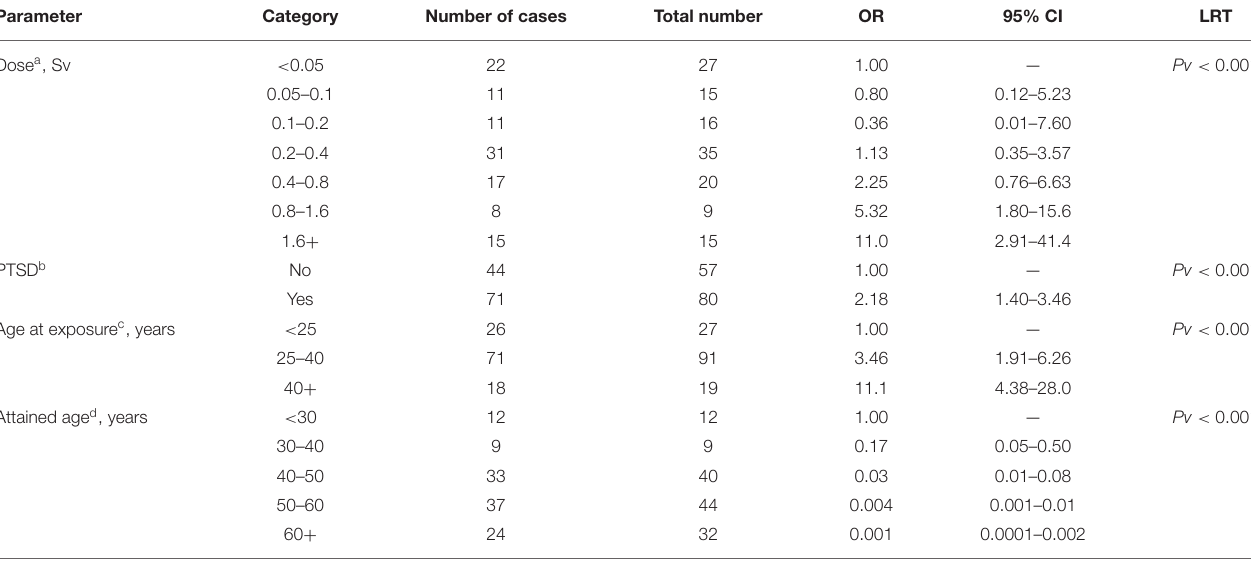
TABLE 5 | Odds ratio (OR), 95% confidence interval (CI), and reliability probability based on probability function (LRT) for the different groups of the clean-up workers. Parameter Category